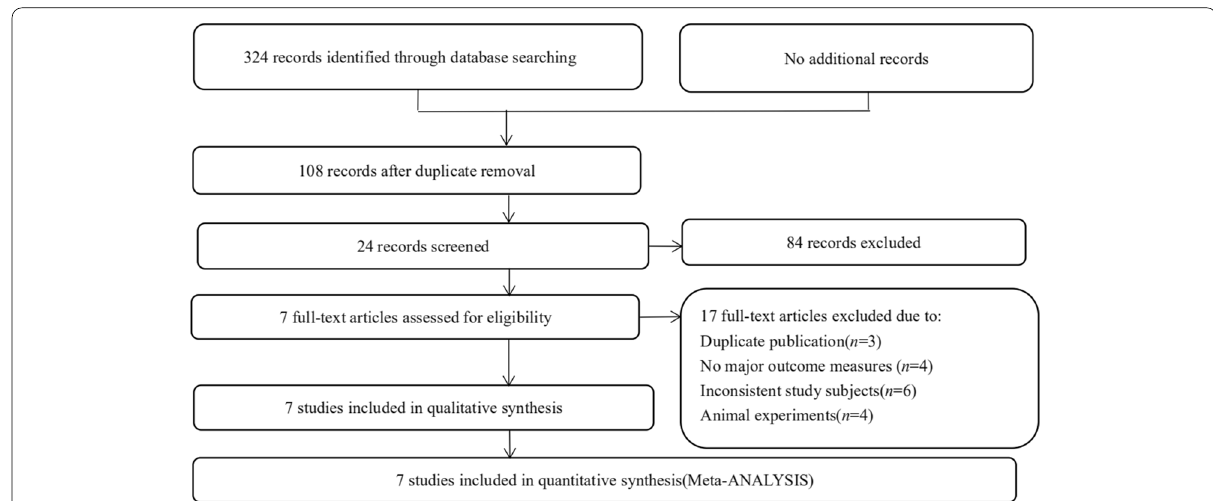
Fig. 1 Flowchart of literature search. "Duplicate removal" refers to the removal of the same documents searched from different databases. After going through the titles, abstracts and full-texts of the 108 included literatures, 84 papers that were obviously inconsistent with the research theme were excluded. The "Inconsistent study subjects" refer to the fact that medial temporal lobe sclerosis was not associated with HHV-6B infection in the